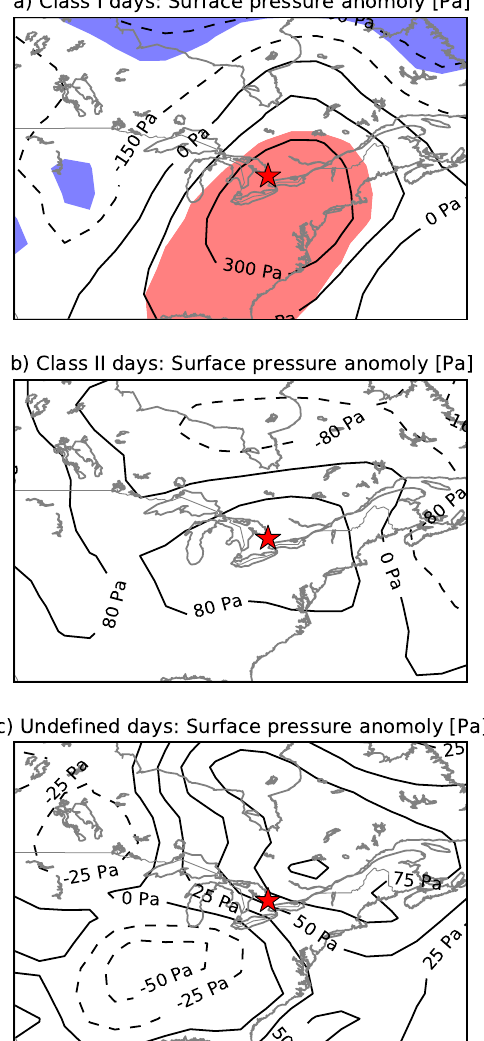
Figure 5. NCEP reanalysis surface-pressure anomaly (Pa) from the 28-day mean for (a) class I, (b) II, and (c) undefined days. Positive 95% significance anomalies are shaded in pink and negative 95% significance anomalies are shaded in blue.